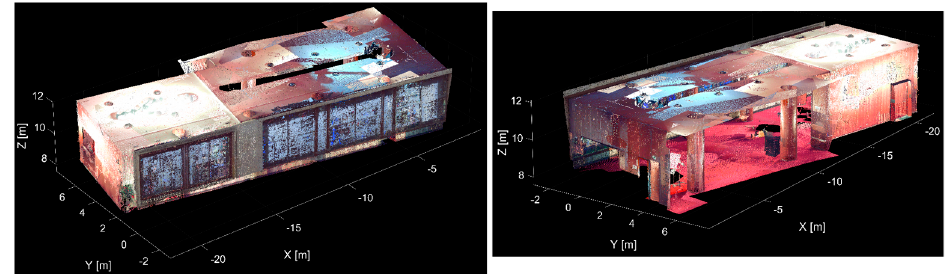
Figure 7. The initial point cloud of a room in the